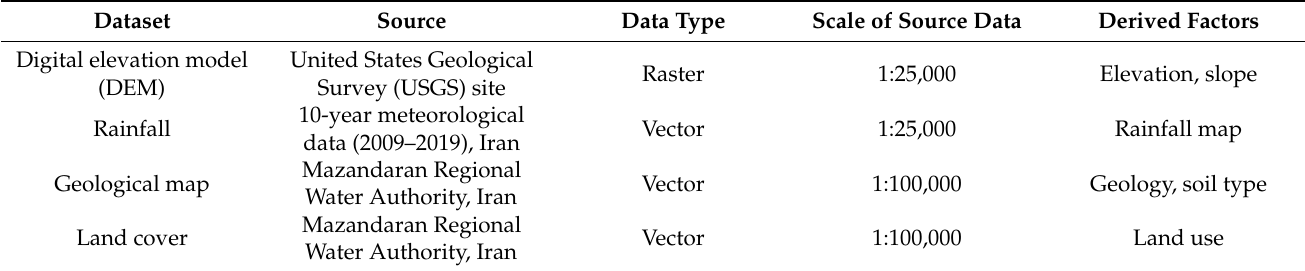
Table 5. Sources and types of applied